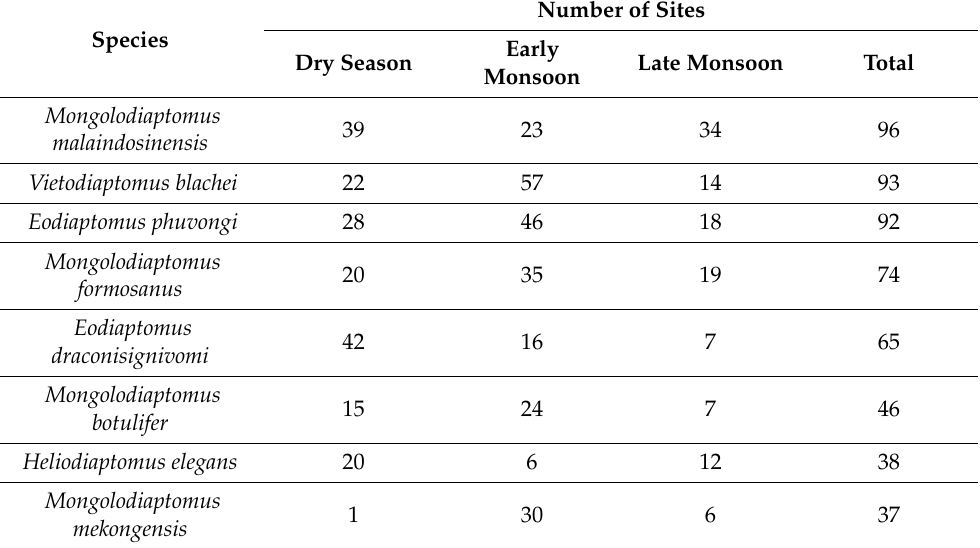
Table 4. The number of sites where common and fairly common diaptomid species were reported throughout three